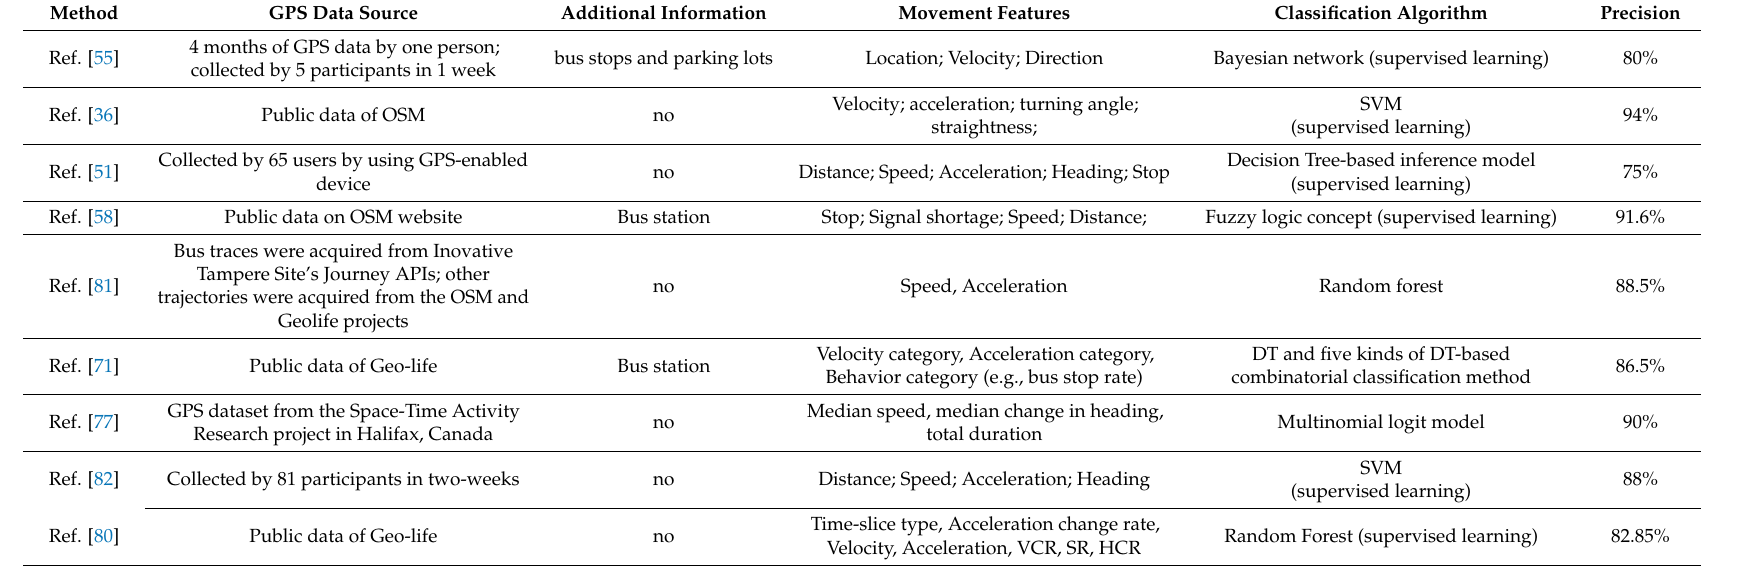
Table A2. MMT classification evaluation based on point-based